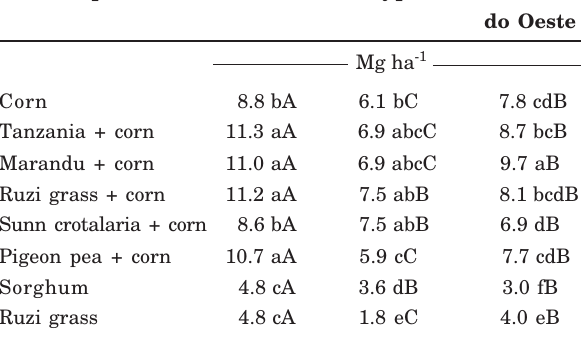
Means followed by the same lowercase letter in a column, and by the same uppercase letter in a row are not significantly different by the Tukey test (p